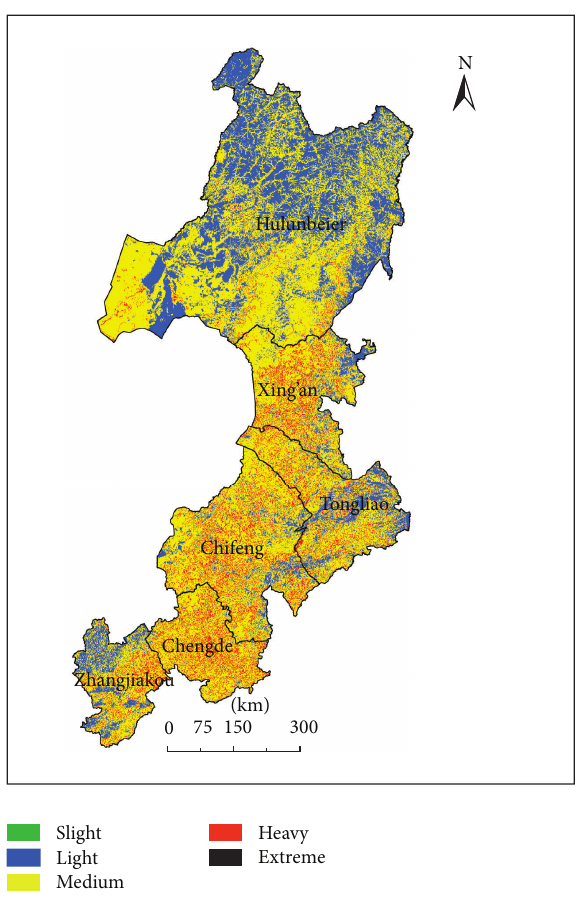
Figure 4: Spatial distribution of ecological vulnerability in